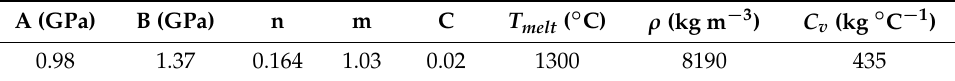
Table 1. Johnson–Cook constitutive model parameters of the Inconel